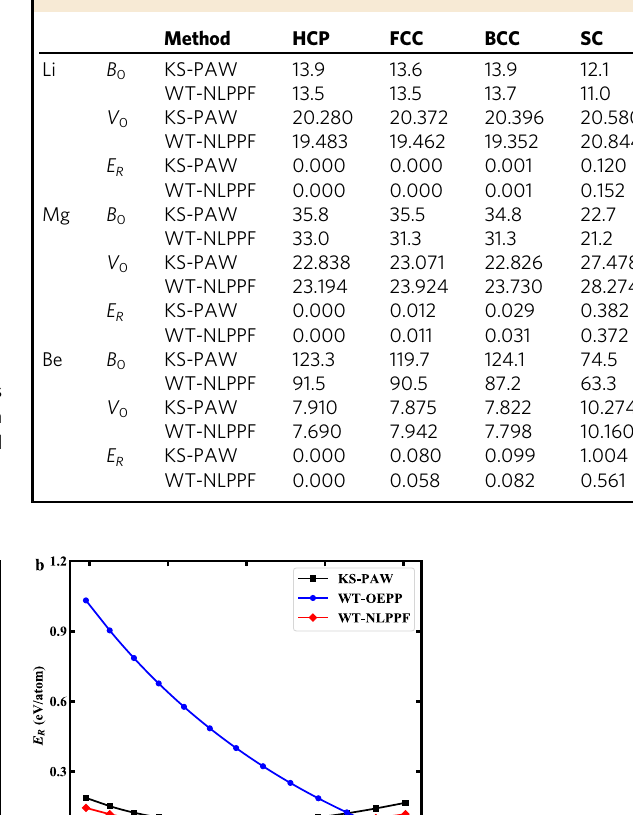
Table 1 B 0 (GPa), E R (eV/atom), and V 0 ( Å 3 /atom) for bulk Li, Mg, and Be by KS-DFT and